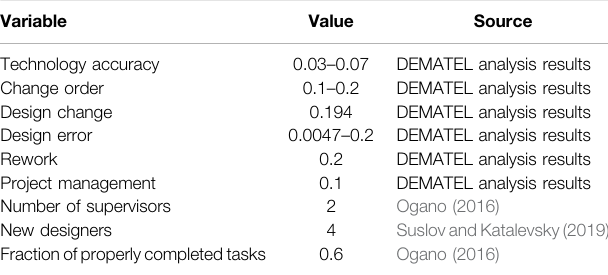
TABLE 6 | Data used in the development of the DEMATEL – SD model of construction delay.